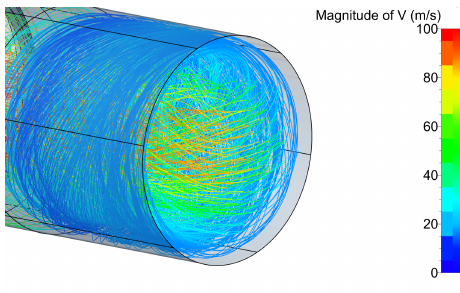
Figure 10. Outlet velocity streamlines.